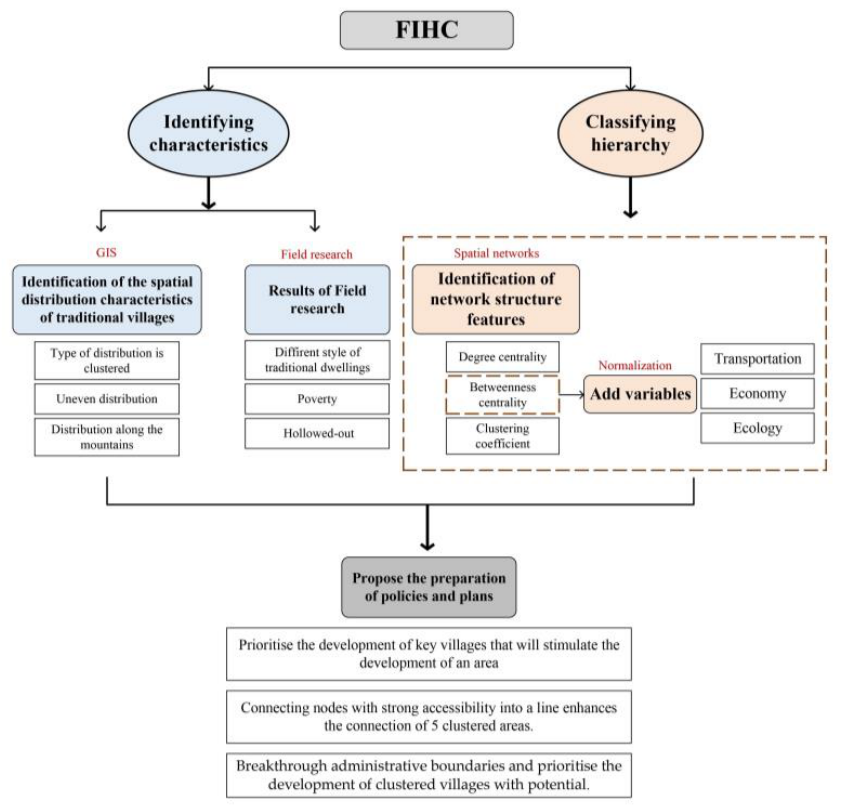
Figure 1. The method framework for Feature identification, Hierarchical classification (FIHC).